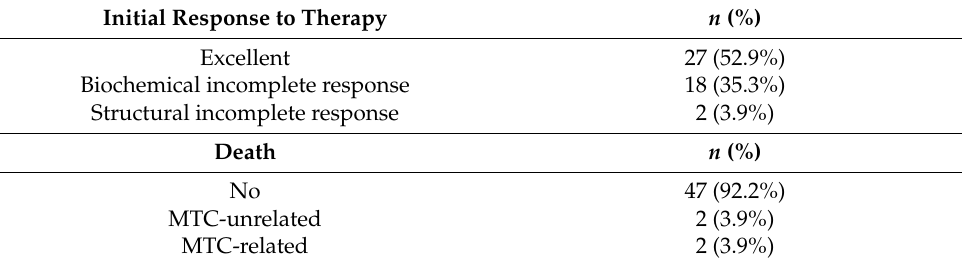
Table 2. Initial response to